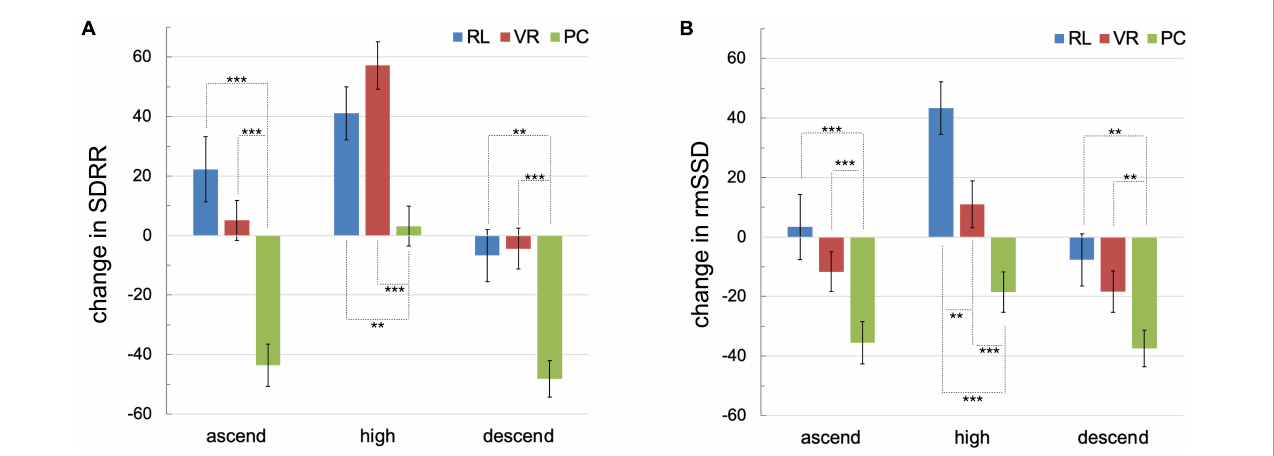
FIGURE4 Changes in the HRV parameters SDRR (A) and rmSSD (B) for the separate phases of the ride in the fire truck’s basket compared to baseline per condition: The phases were corrected for the baseline (delta = HRV during the respective phase minus HRV during the baseline). The zero line thus marks the baseline, which was therefore not depicted separately. The error bars depict the standard deviation. Significant differences between groups are marked respectively (** p < 0.01, *** p < 0.001).